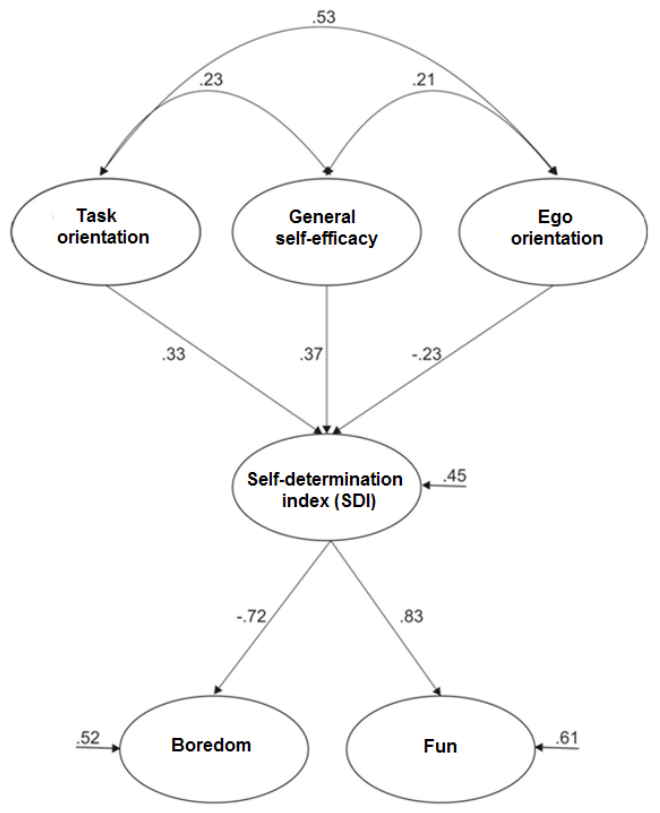
Figure 1. Structural regression model to analyze the relations between goal orientations, self-efficacy and satisfaction in sport (fun and boredom). All parameters are standardized and are significant at p <